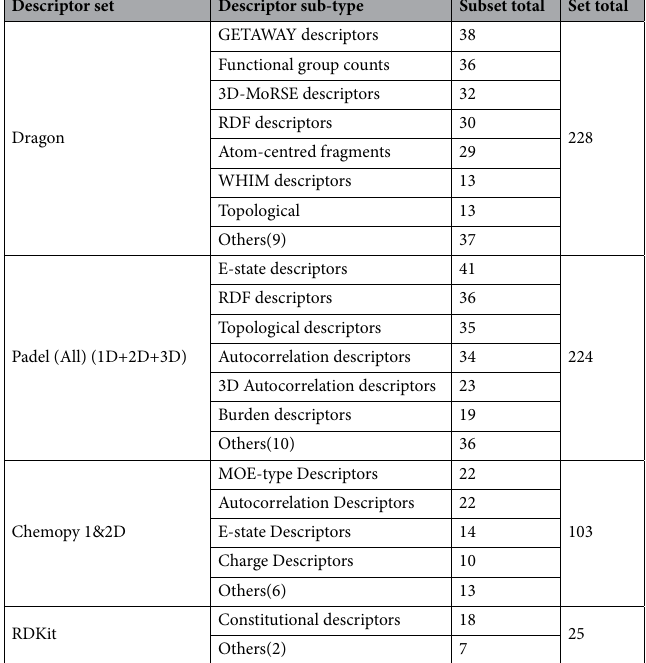
Table 4. Number of final descriptors grouped over all tasks by sub-type.